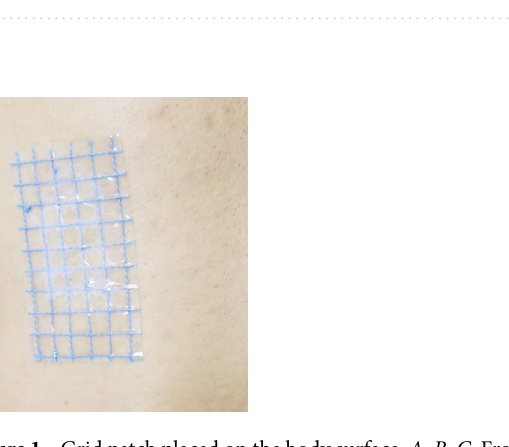
Table 1. The detailed information of patients. BMI, body mass index.